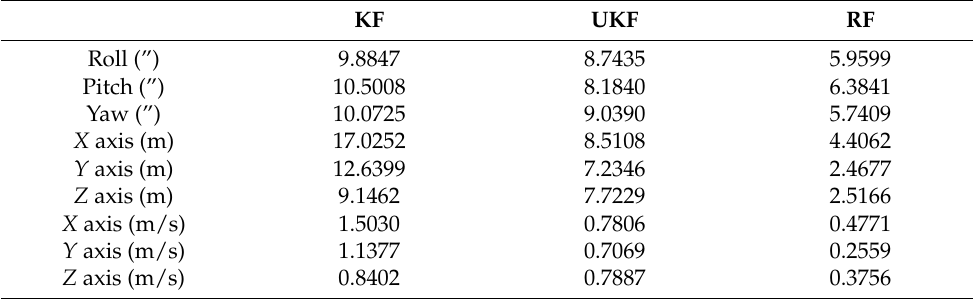
Table 3. Root mean square error data estimated by three algorithms (Condition A).